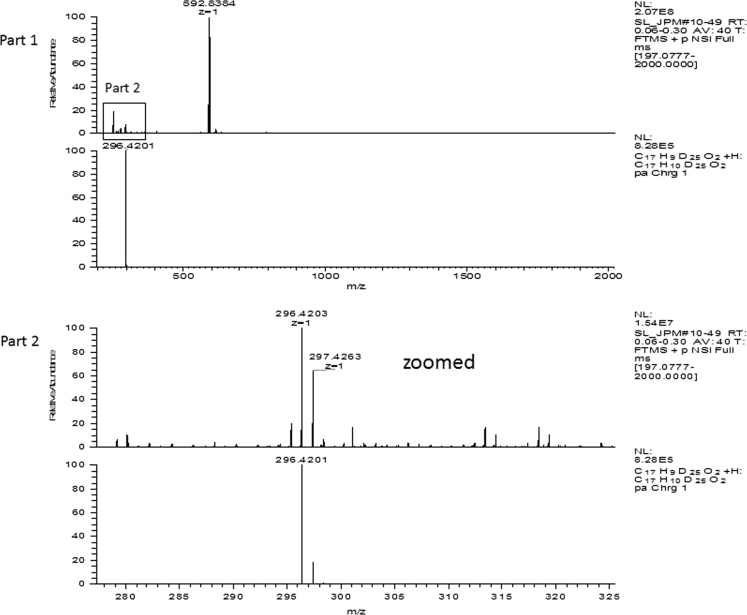
HR-MS spectra of the purified IPMdeut. Found: 296.4203 [M+H]+, 592.8384 [2M+H]+; calcd: 296.4201 [M+H]+, 592.8402 [2M+H]+.